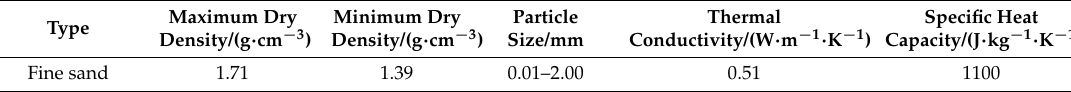
Table 1. Physical and thermal parameters of the